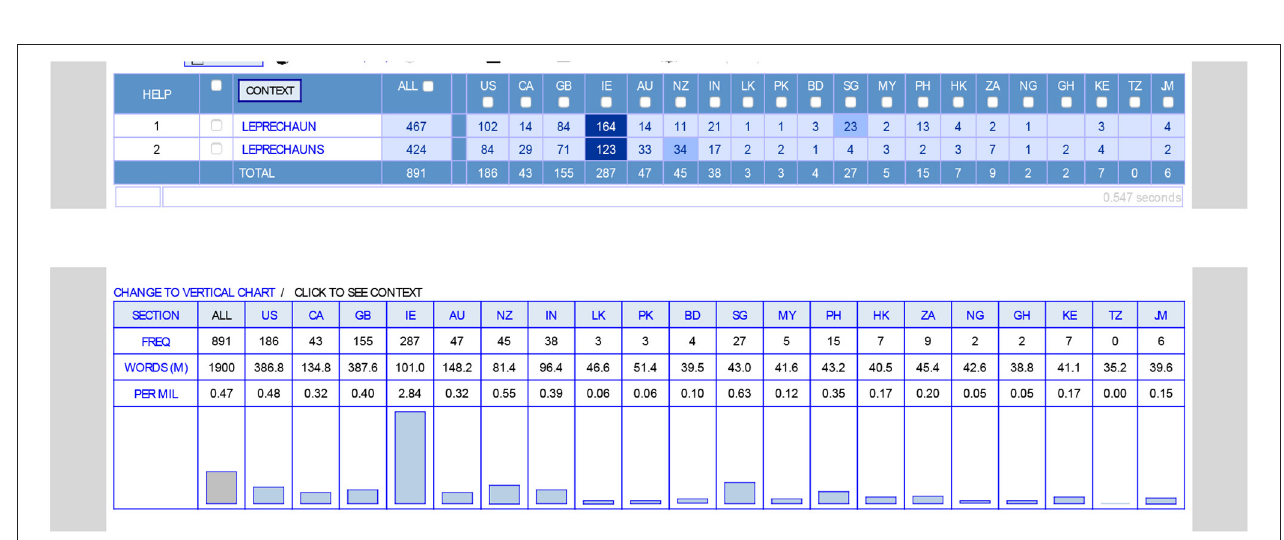
FIGURE 16 | Distribution of langers in the GloWbE Corpus (from https://www.english-corpora.org/glowbe/).